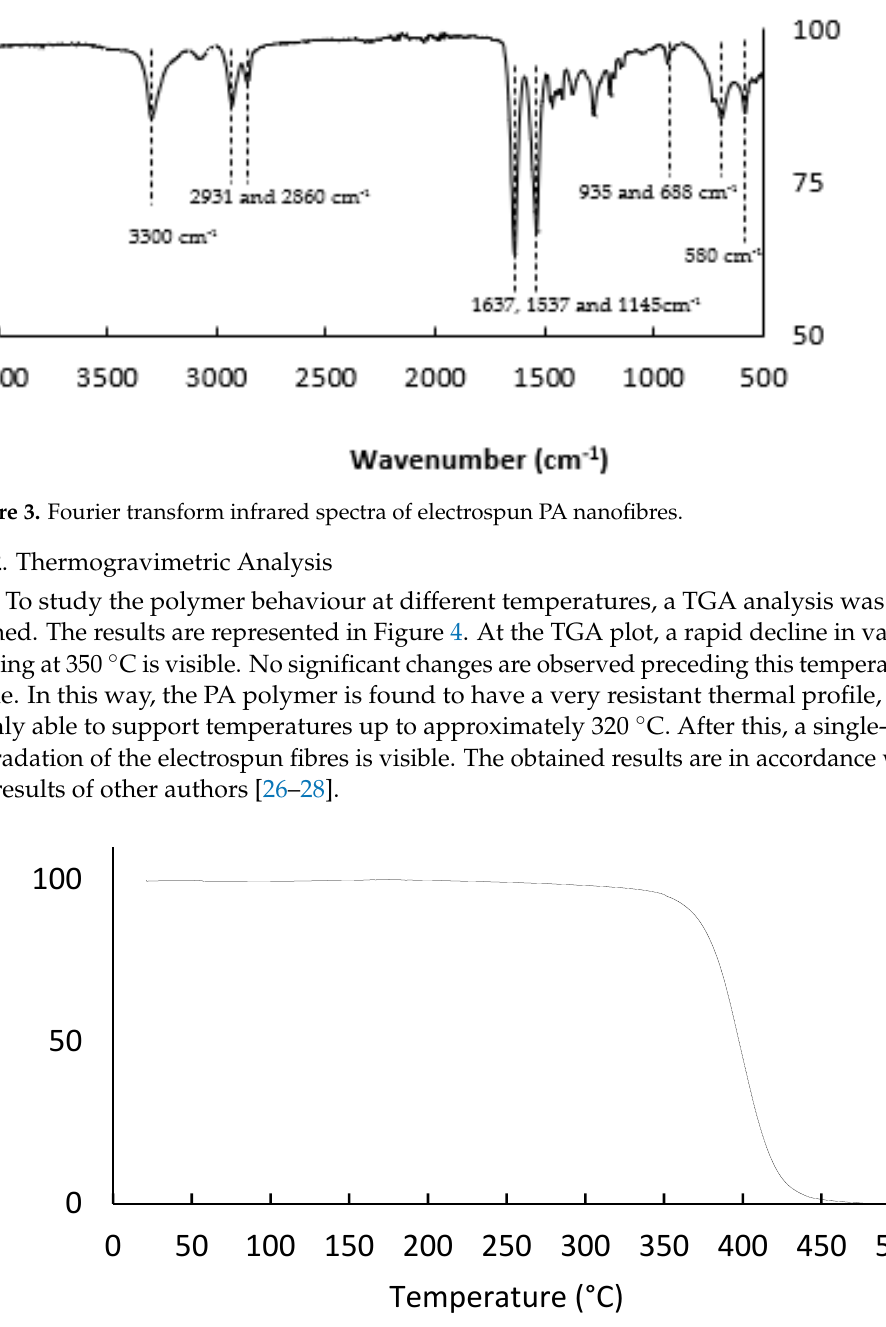
Figure 4. Thermogravimetric analysis curves of electrospun PA nanofibres.